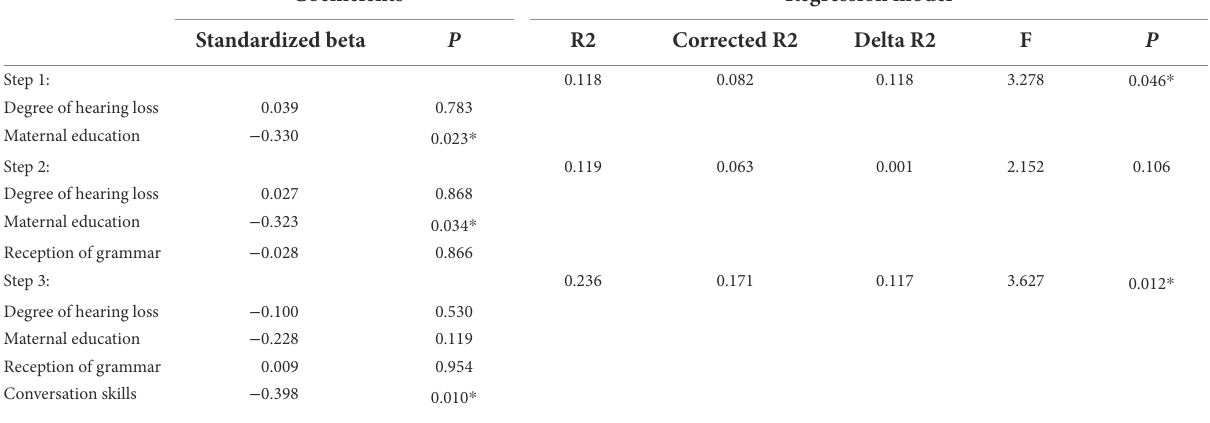
TABLE 6 Regression analysis to predict SDQ emotional problem scores as reported by